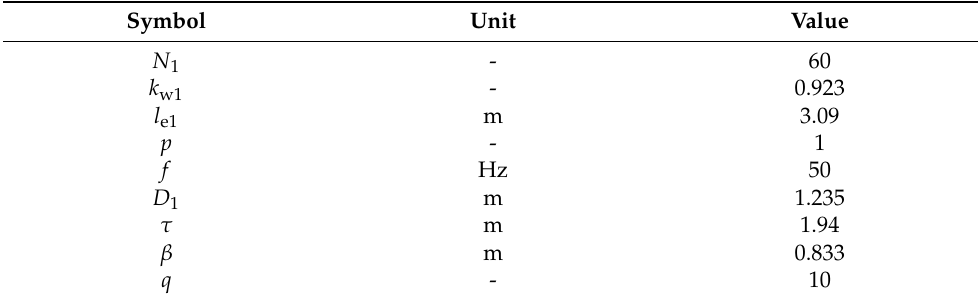
Table 2. Calculation results of the stator leakage reactance of the TWW-200-2A synchronous generator. Parameter Acc. to Abramov Acc. to D ˛abrowski Acc. to Richter Acc. to Cioc and Nica X e ,